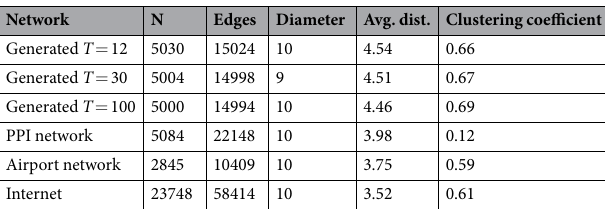
Network N Edges Diameter Avg. dist. Clustering coefficient